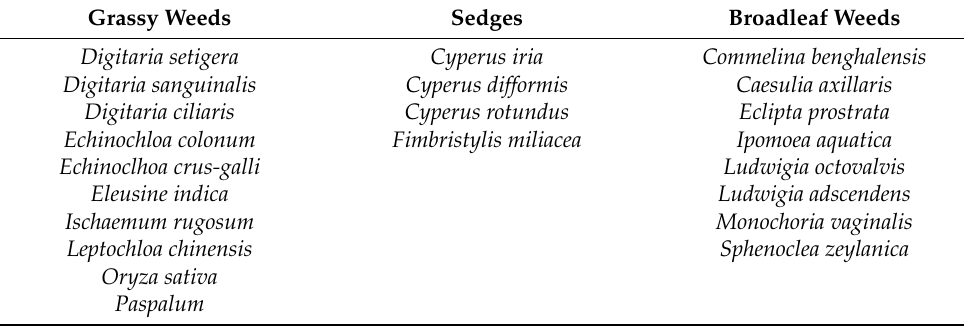
Table 1. Weeds species in Asia’s rice field. Grassy Weeds